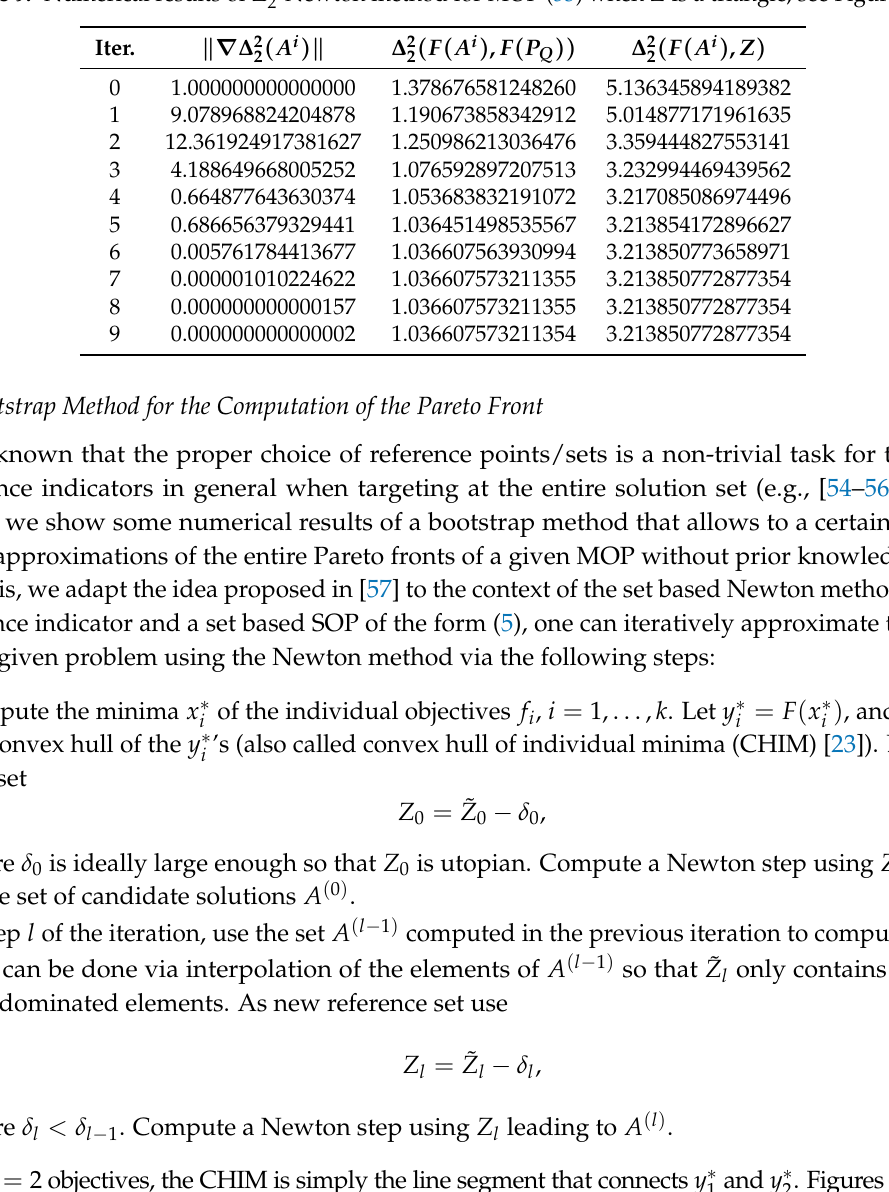
Table 9. Numerical results of ∆ 2